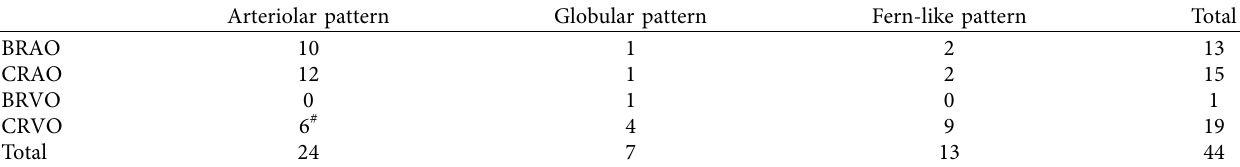
Table 3: The distribution of three types of PAMM with different